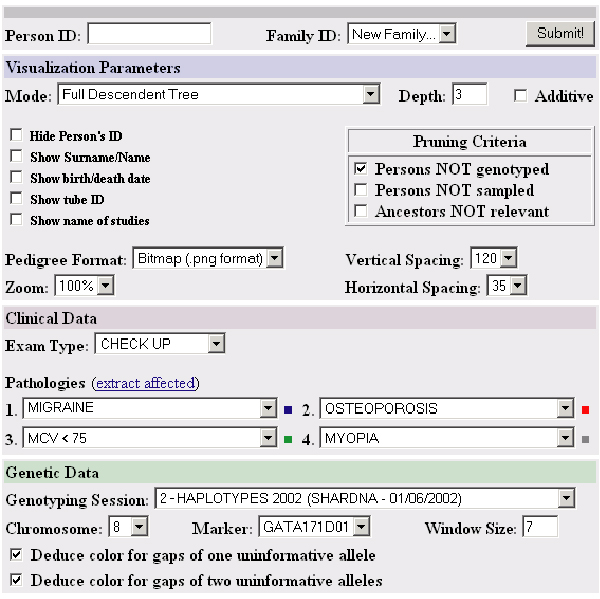
PedNavigator main menu The main menu is a web form divided into separated panel. The Visualization panel contains settings about visit modes, pruning criteria, zoom level and output format. The Clinical Data panel is designed to select up to four pathologies or traits, associated with persons, coloured according to the small square near the select box. The Genetic Data panel permits to choose markers and chromosomes to draw under individual's symbols.